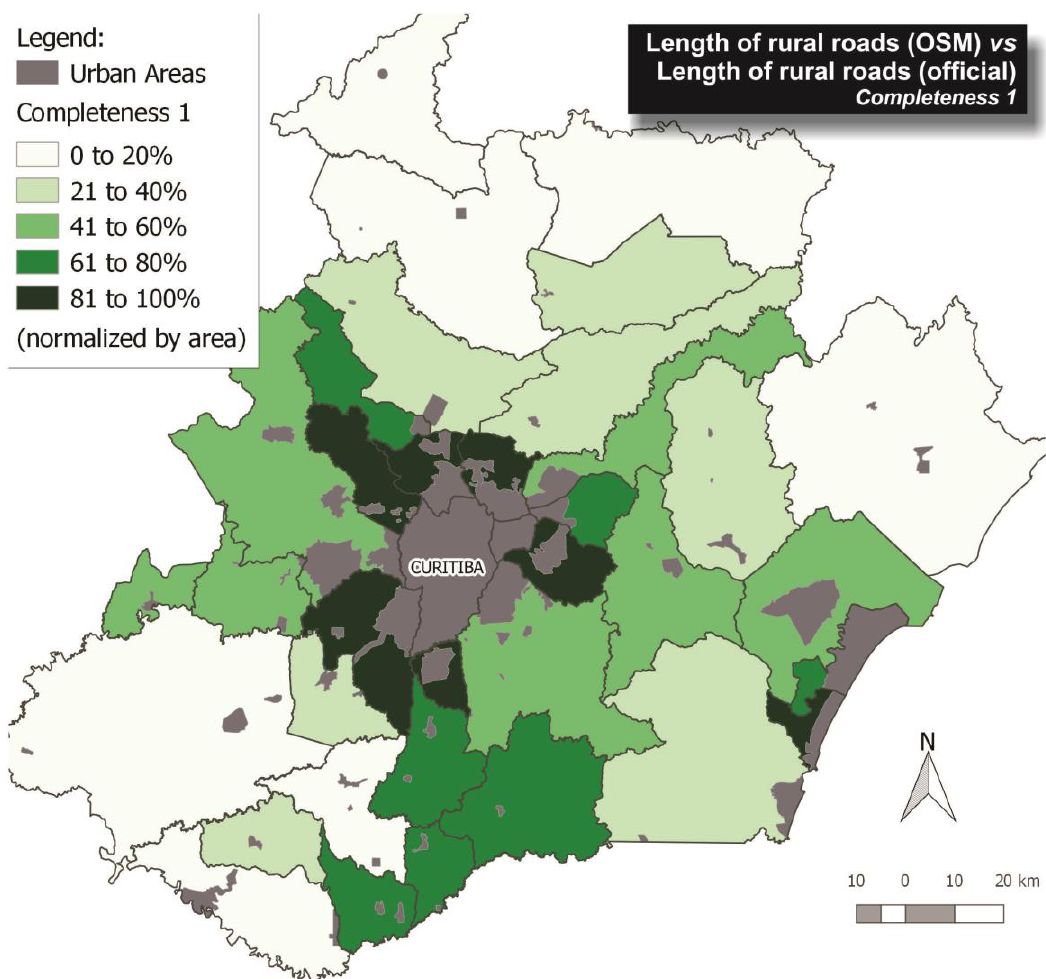
Figure 6. Completeness 1: Length of rural roads from OSM base vs. Length of rural roads from the official topographic mapping (at 1:250,000